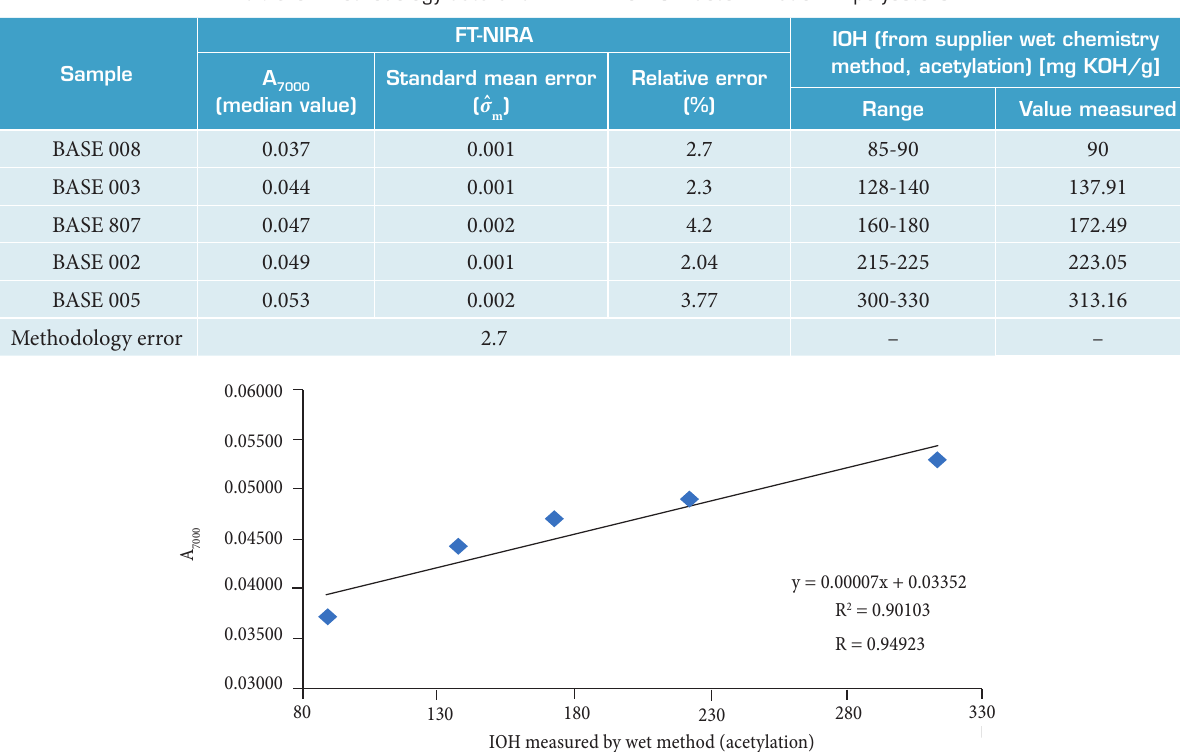
Table 6. Methodology data and FT-NIRA for IOH determination in polyesters.